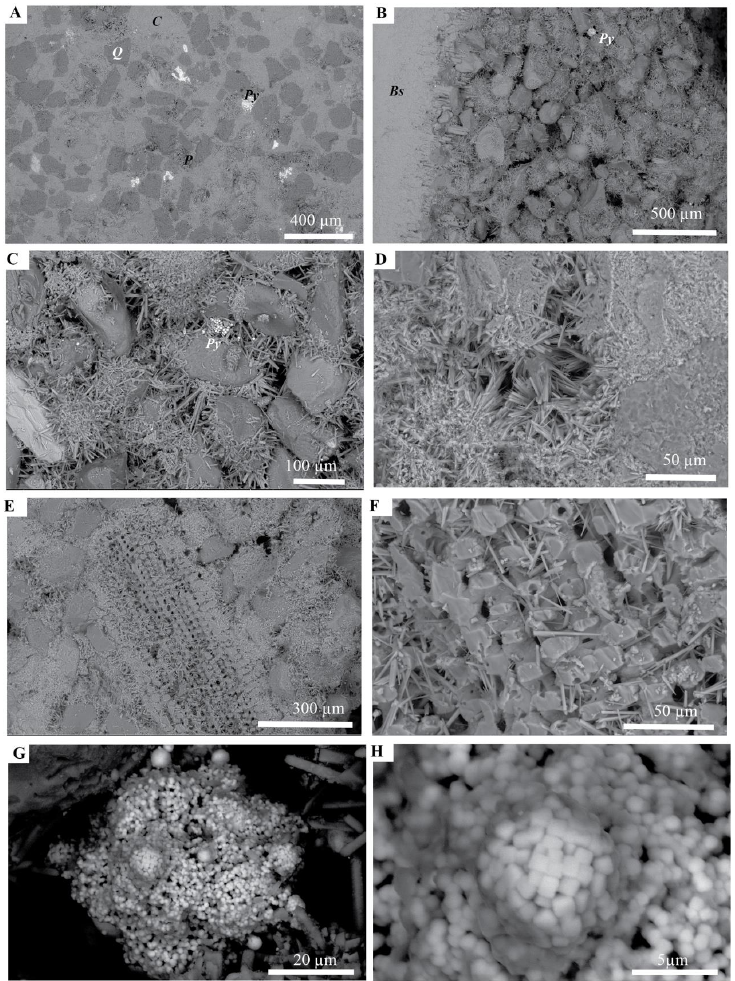
Figure 3. Backscattered electron (BSE) micrographs of hardground features and fabric. ( A ) Highly carbonate cemented area of matrix. C = carbonate particle, Q = quartz, Py = pyrite and P = more porous area, with less cement. ( B – D ) Increasing magnification views of typical areas with aragonite acicular cement. In ( B ), the left-hand side illustrates bivalve shell, with aragonite fringe. ( E , F ) Carbonate particle (echinoderm spine), with aragonite fringe. ( G , H ) Details of pyrite framboids, associated with organic material (darker grey).